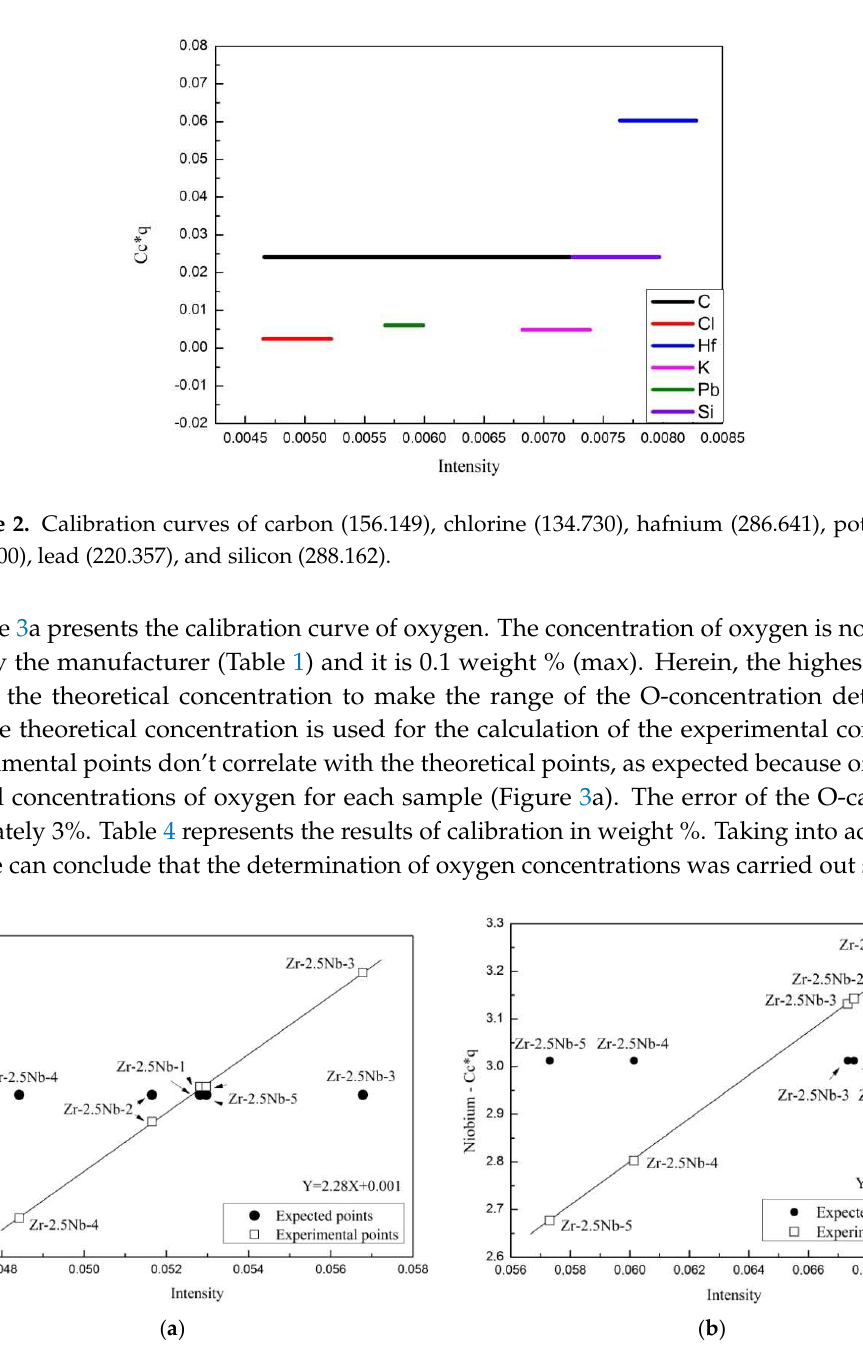
Figure 3. Calibration curves of ( a ) oxygen (130.492) and ( b ) niobium (316.345).